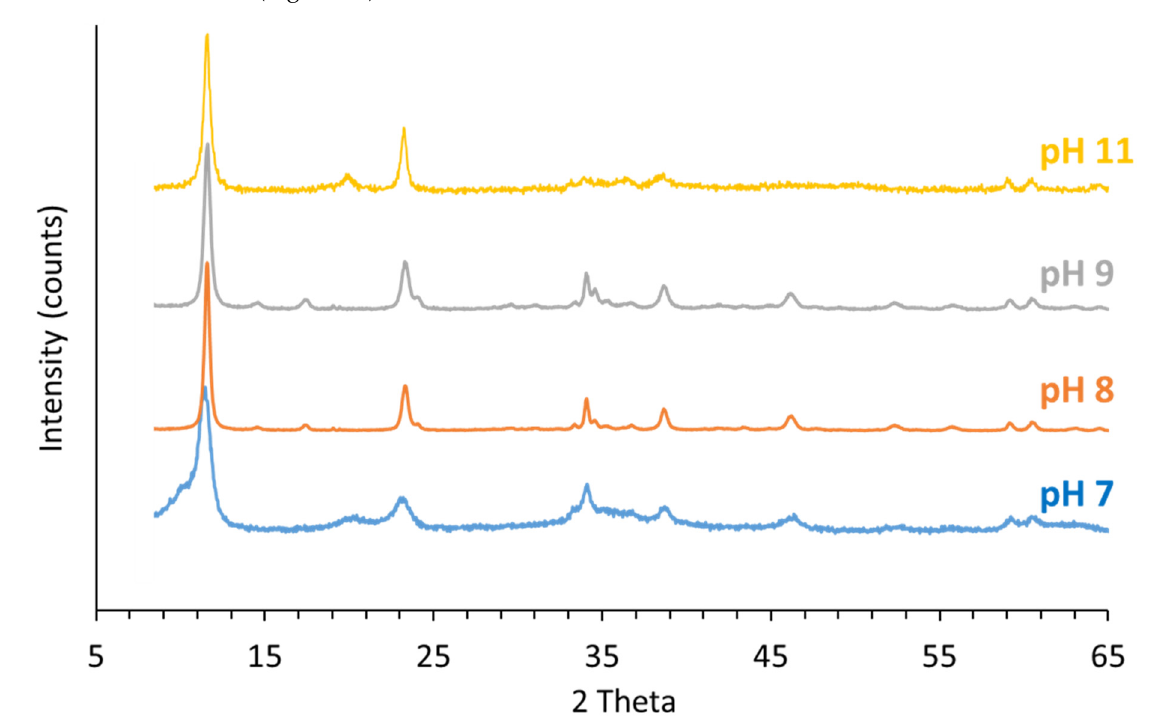
Figure 4. PXRD pattern of the solids collected after aging. Table 2. XRD data provided by the Rietveld refinement method for the solids obtained from pH 7 to 11 after aging. Solids Obtained from pH 7 to